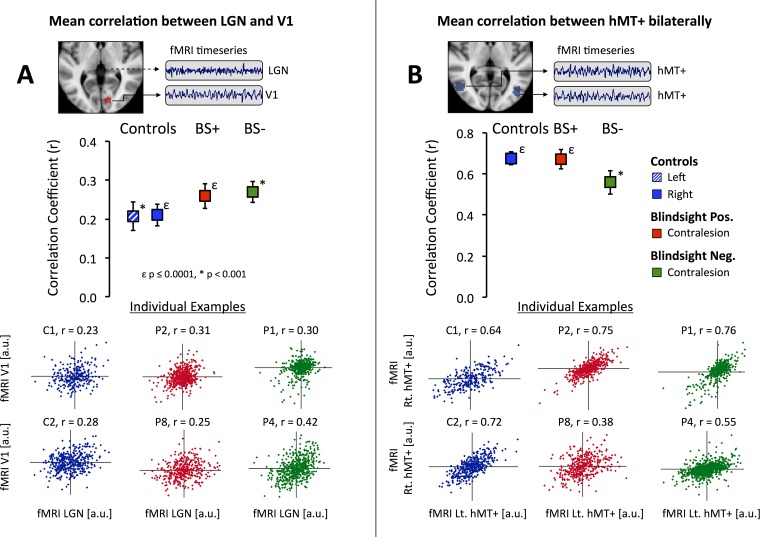
Functional connectivity of the visual pathways in patients and controls.(A) Correlation of LGN and V1 in the same (undamaged) hemisphere over the entire fMRI timeseries, after stimulus-evoked activity has been regressed out. (B) Correlation of hMT+ bilaterally. Box plots show Fischer-corrected mean correlation coefficients comparing participant group ± SEM. Statistical symbols represent significance levels for one sample t-tests against baseline (zero): ε p ≤ 0.0001, * p < 0.001. Scatterplots are individual examples of fMRI signal in ROI1 versus ROI2. Each point represents a single fMRI volume. Plots for patients in panel A are correlations in the contralesional hemisphere. BS+ is blindsight positive, and BS- blindsight negative. Underlying data can be found in S2 Data. fMRI, functional MRI; LGN, lateral geniculate nucleus; ROI, region of interest; SEM, standard error of the mean; V1, primary visual cortex.